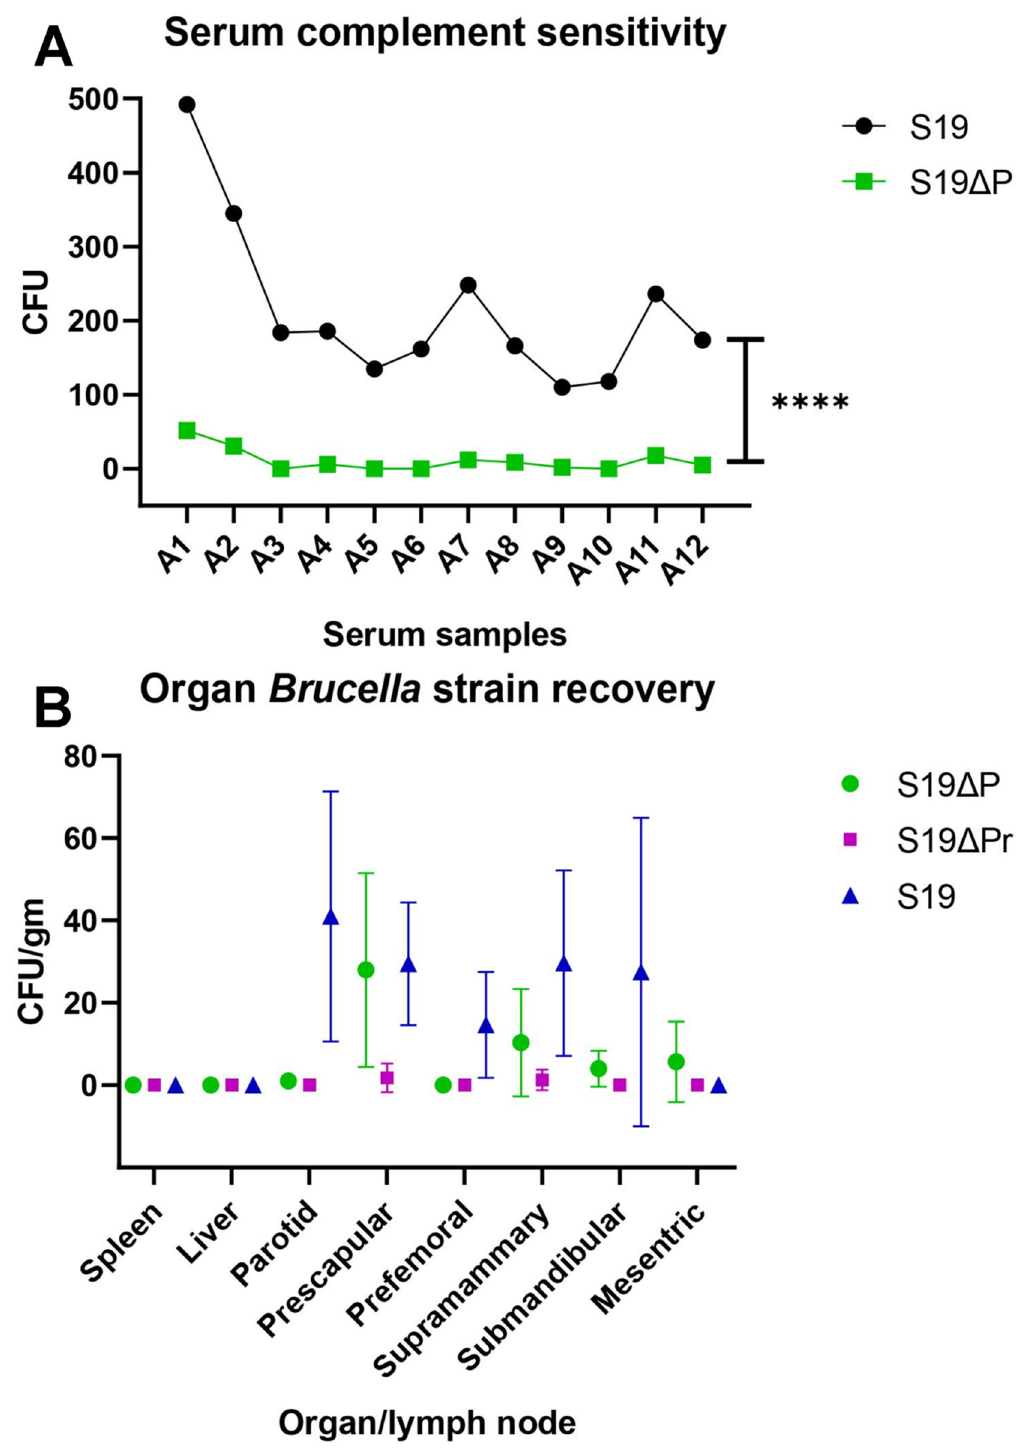
Figure 4. Persistency of Brucella vaccine strains in vitro and in vivo. ( A ) Serum complement sensitivity assay. The sus- ceptibility of the Brucella strains against complement killing was determined. The S19 strain was relatively resistant to complement killing, while S19 ∆ per strain was highly susceptible to complement killing. The test was performed using fresh serum complement harvested from 12 buffalo calves (A1–A12). **** p ≤ 0.0001 by paired t -test. ( B ) Brucella vaccinating strain recovery from organ-wise. The residual virulence of S19 ∆ per candidate vaccine was measured by the bacterial burden in the vaccinated animals. At 42 dpi, load of S19 ∆ per was lower than S19 strain in inoculated